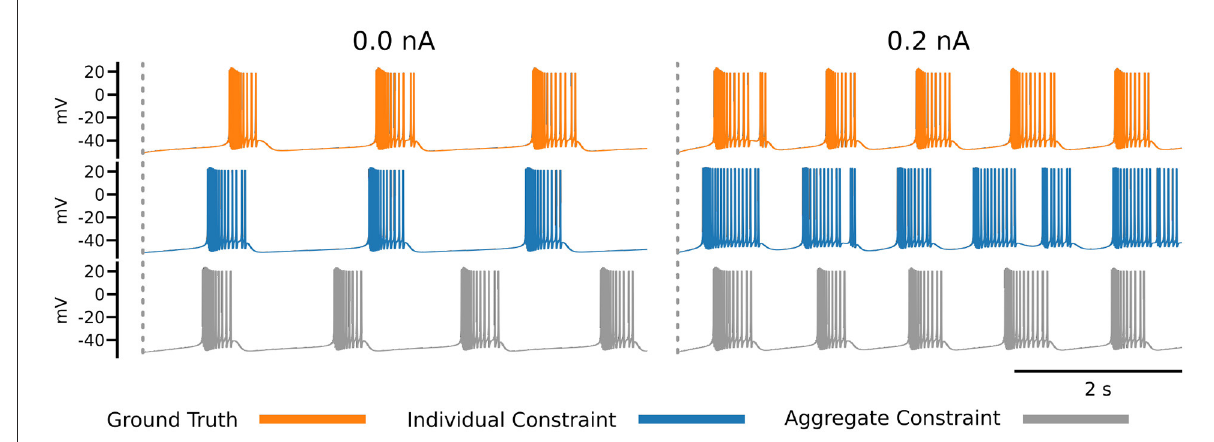
FIGURE7 Each row of this figure shows the voltage traces for the ground truth (top orange), for the best solution sets given the individual constraints (middle blue) and the best solution set given the aggregate constraint (bottom gray). Each column shows the traces for different injected currents. Loss values for these parameter solution sets are 0.0008 for the 0.0 nA individual constraint, 0.0348 for the 0.2 nA individual constraint, and 8.8109 for the aggregate